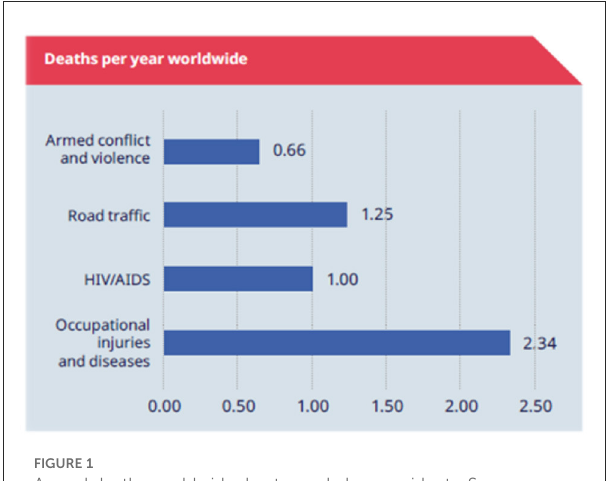
FIGURE1 Annual deaths worldwide due to workplace accidents. Source: Laszcz-Davis (3).